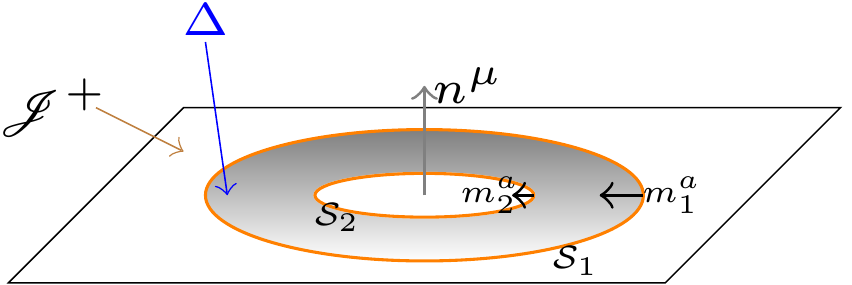
Figure 4. Schematic representation of a region ∆ in J + when Λ > 0 bounded by two disjoint cuts S S 2 . The vector fields m 1 and